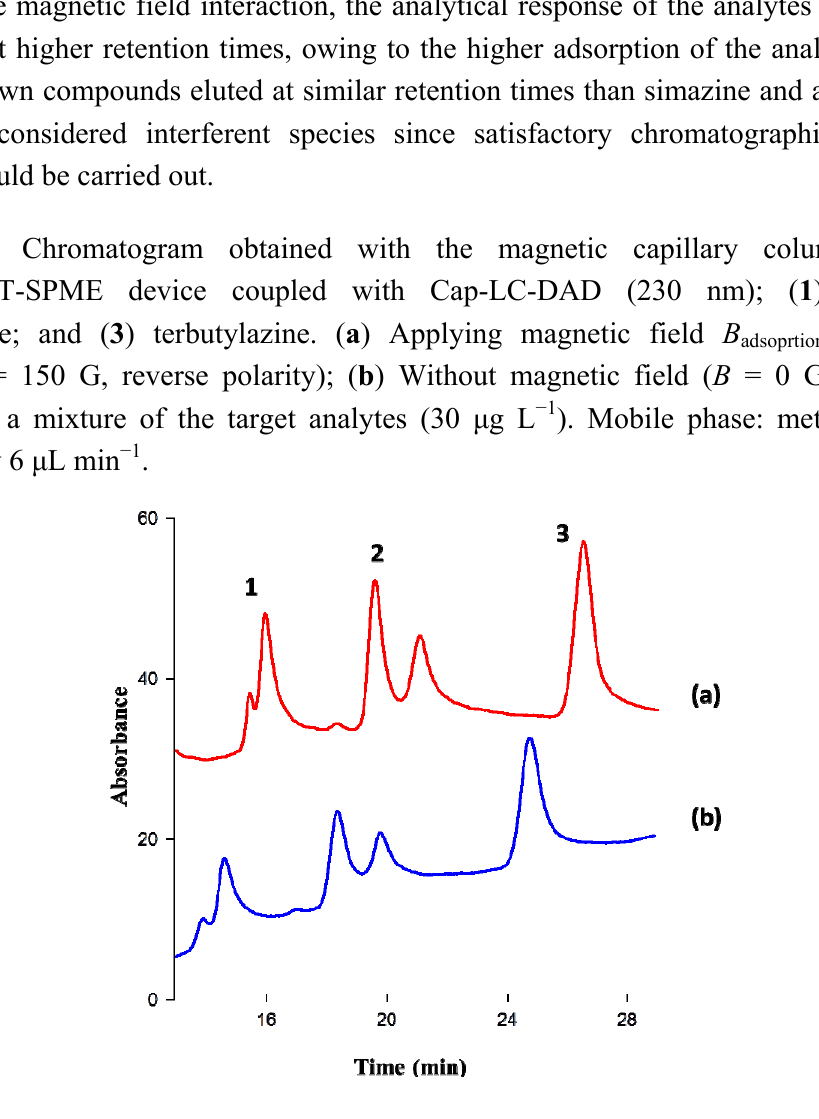
= 150 G adsoprtion